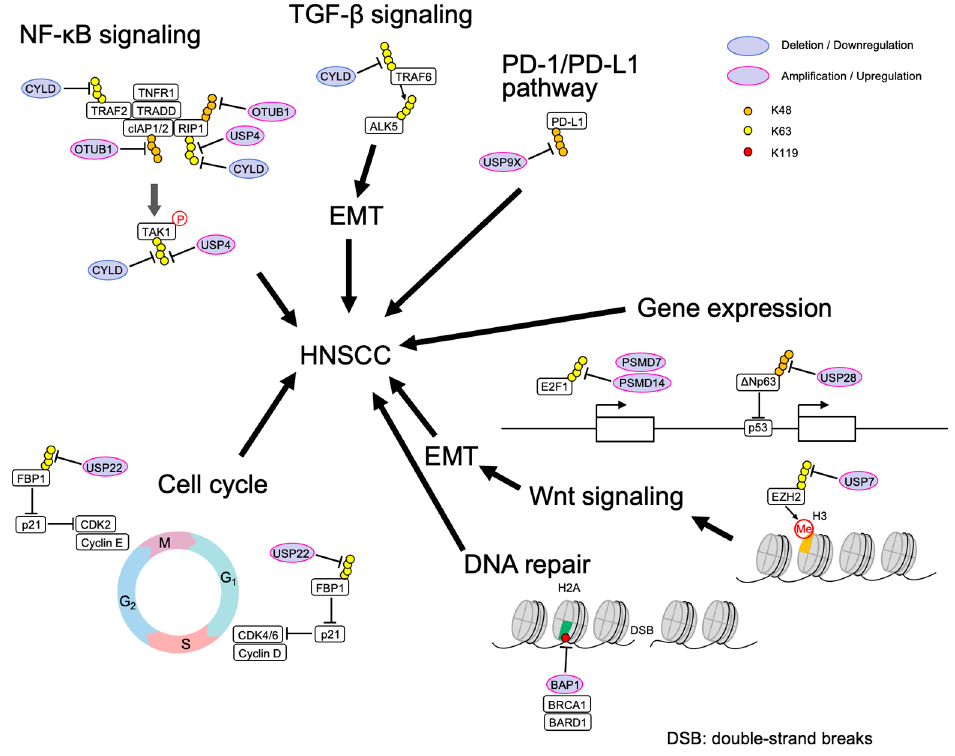
Figure 2. Involvement of DUBs in HNSCC.